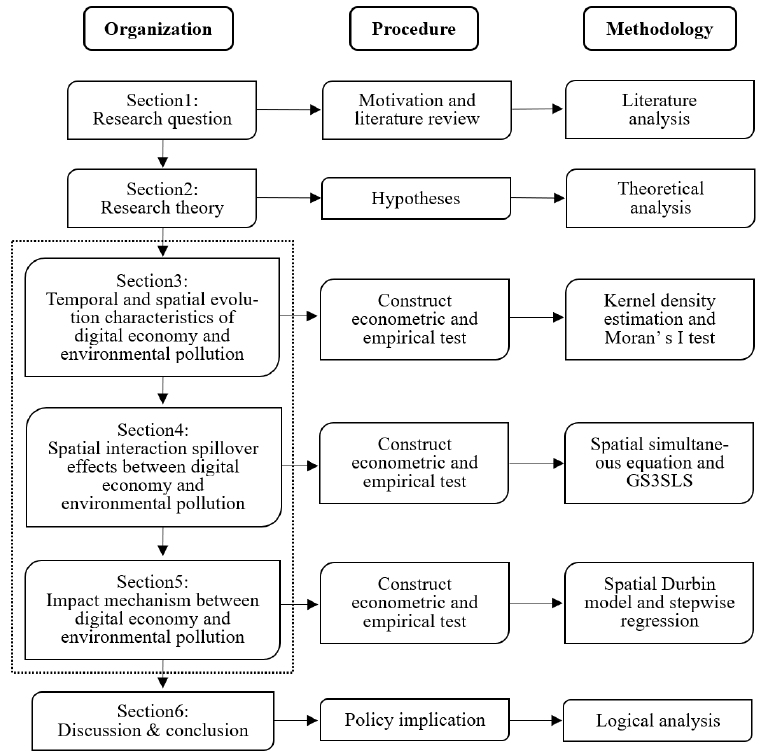
Figure 1. The logical